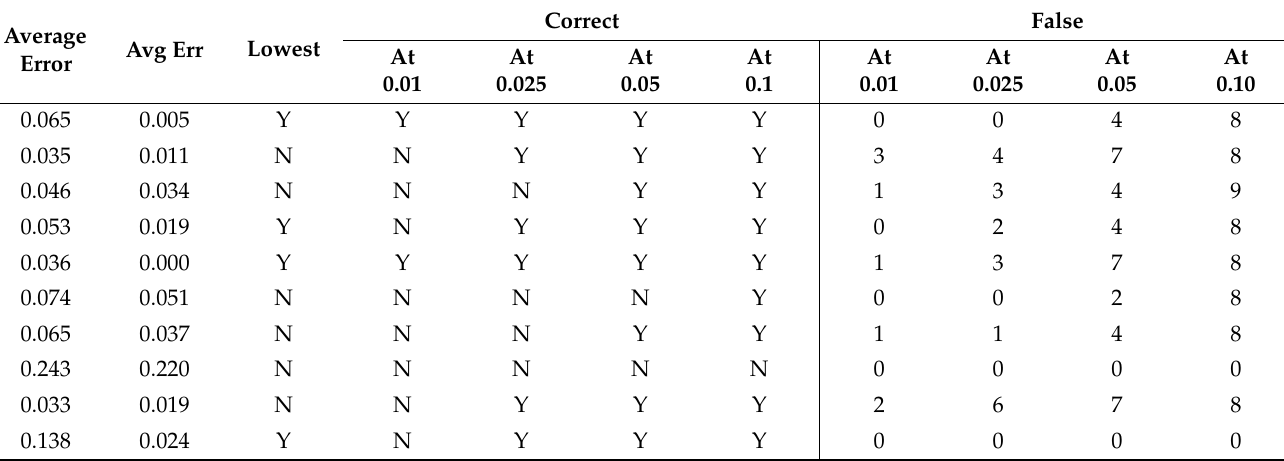
Table A213. Set 3, trials 31–40 summary data (single 0.5 PR